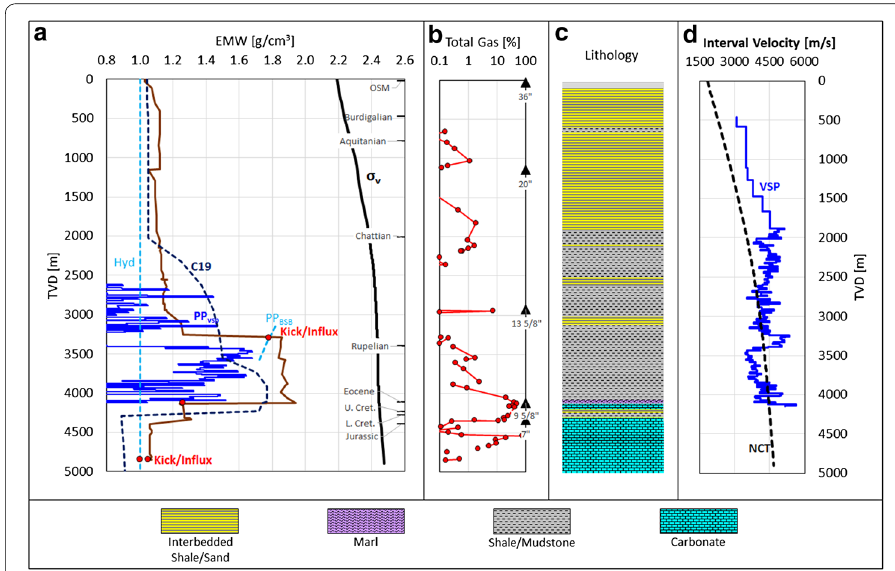
Fig. 10 Pore pressure overview of the Geretsried GEN-1 well. a Pore pressure gradient estimate. TVD, true vertical depth; EMW, equivalent mud weight; PP vsp , pore pressure from vertical seismic profile (dark blue dotted line); C19, pore pressure from best fit 3D basin model (dark blue dashed line); Hyd, hydrostatic/normal pressure (dashed light-blue line); MW, drilling mud weight (brown line); Kicks/Influx, pore pressure estimates from influxes (red dots); PP BSB , water pore pressure gradient (dotted light-blue line) tied to the kick pressure in the Baustein Beds at 3285 m; σ v , vertical stress (black line). b Total gas readings while drilling on a logarithmic scale in percent (red line and red dots) and casing points (black triangles). c Simplified lithological column. d Interval velocities from vertical seismic profile (blue line) and normal compaction trend to estimate pore pressure (black dashed